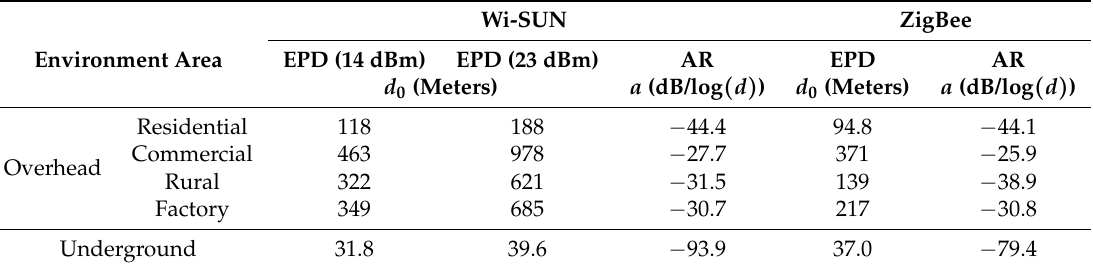
Table 3. EPD and the AR for the wireless communications.